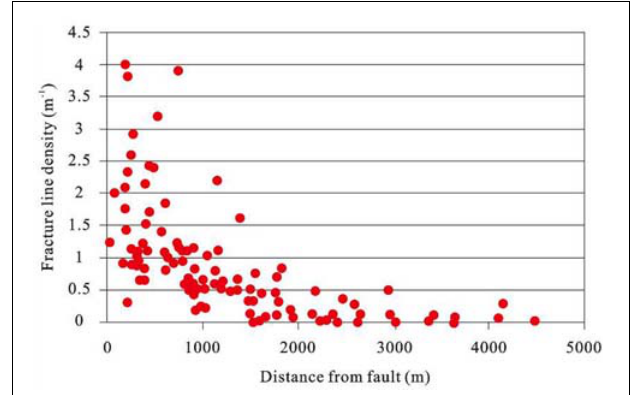
FIGURE 8 | The relationship between fracture density and distance from the fault.